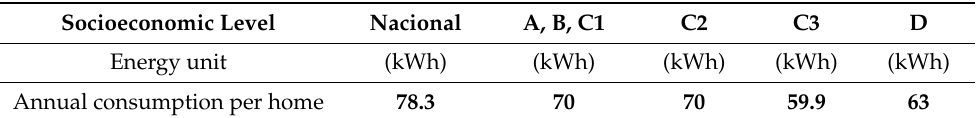
Table 3. Monthly energy consumption for cooking, by socioeconomic level and on a national scale [kWh].